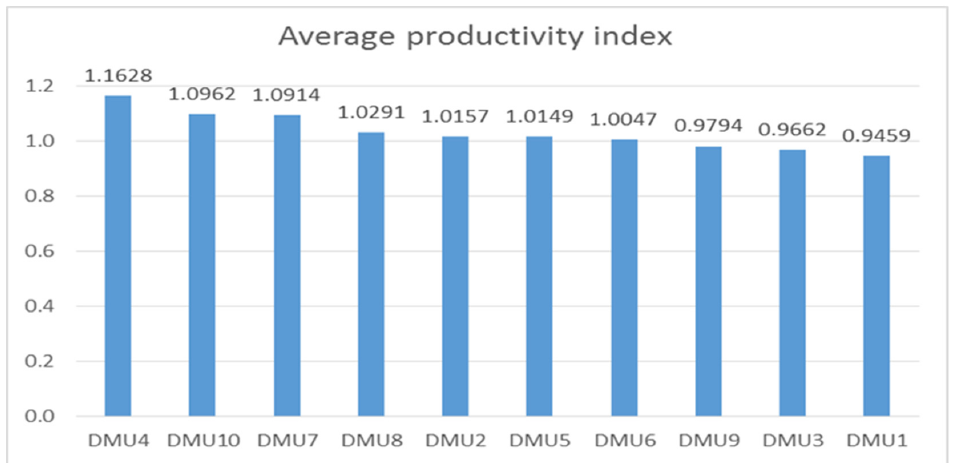
Figure 9. The average Malmquist indices of decision-making units (DMUs) for the period 2017–